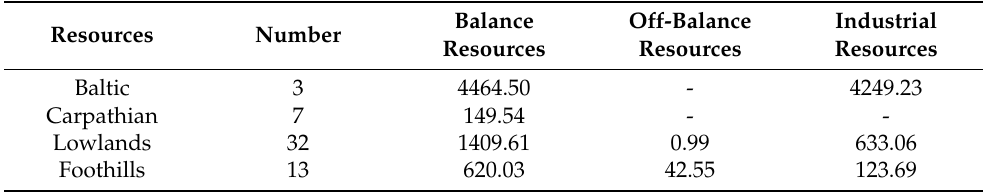
Table 1. Natural gas deposits, as of 31 December